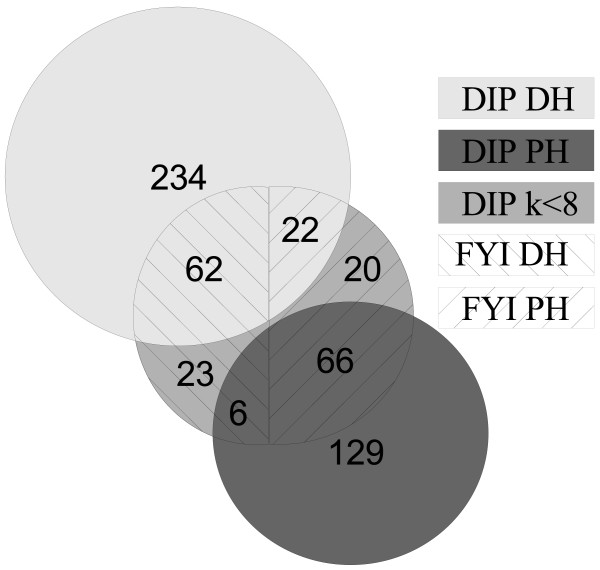
Hub assignment. The overlap between date hubs (DHs) and party hubs (PHs) in the two data sets; DIP and FYI. In FYI there are 108 PHs and 91 DHs (middle circle), of which 23 DHs and 20 PHs have connectivities below the hub threshold (k < 8) in DIP. Most of the FYI PHs (66) were confirmed as PHs in the DIP set, while 22 fell below the PCC cutoff (see Materials and methods). Furthermore, while most of the FYI DHs retained their DH status using DIP, a small fraction of the FYI DHs (6) were classified as PHs. Finally, 234 and 129 previously unclassified hubs were assigned as DHs and PHs in DIP.